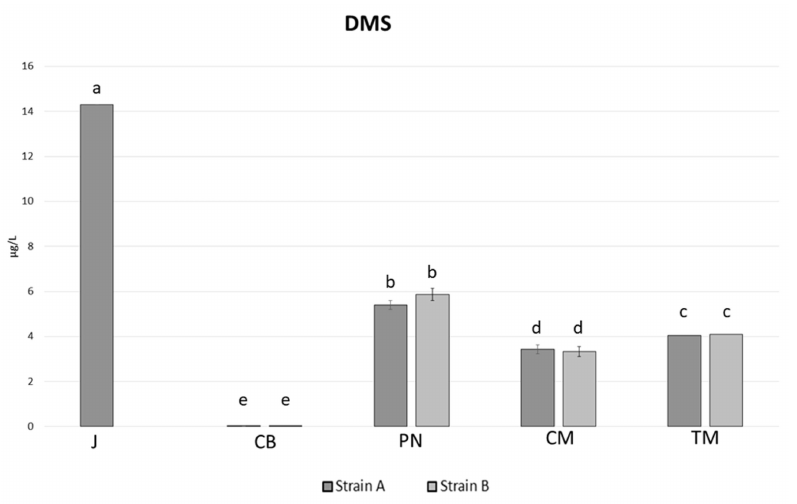
Figure 1. Dimethyl sulphide (DMS) amount found in apple juice (Juice), in base cider (Cider), P é t-Nat, pressured-tank Charmat method (Charmat), and traditional bottle-fermented cider (Champenoise) inoculated with Torulaspora delbrueckii strain A or strain B. Data are reported as average and error bars indicate the standard deviation. Different letters identify significant differences ( p <